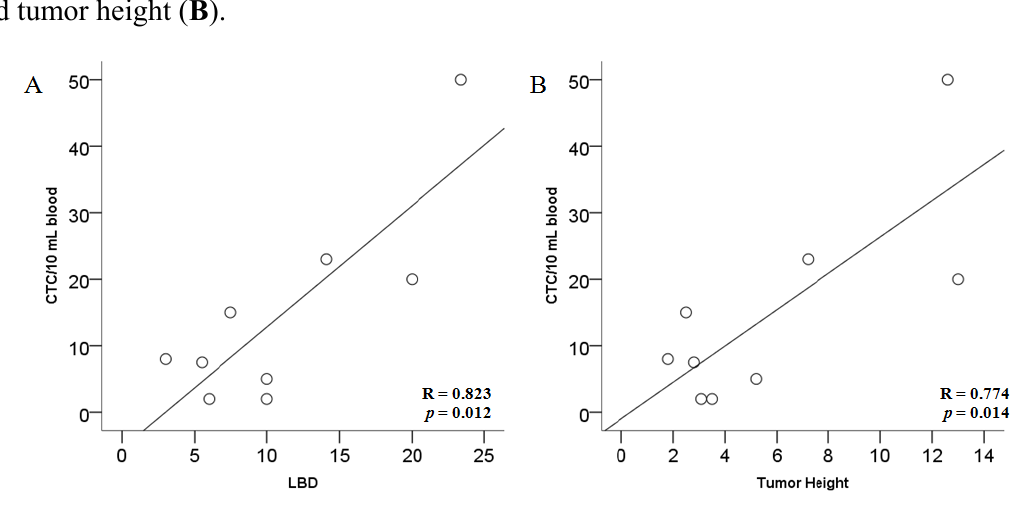
Figure 3. Linear regression analysis between CTC count and lager basal diameter LBD ( A ) and tumor height ( B